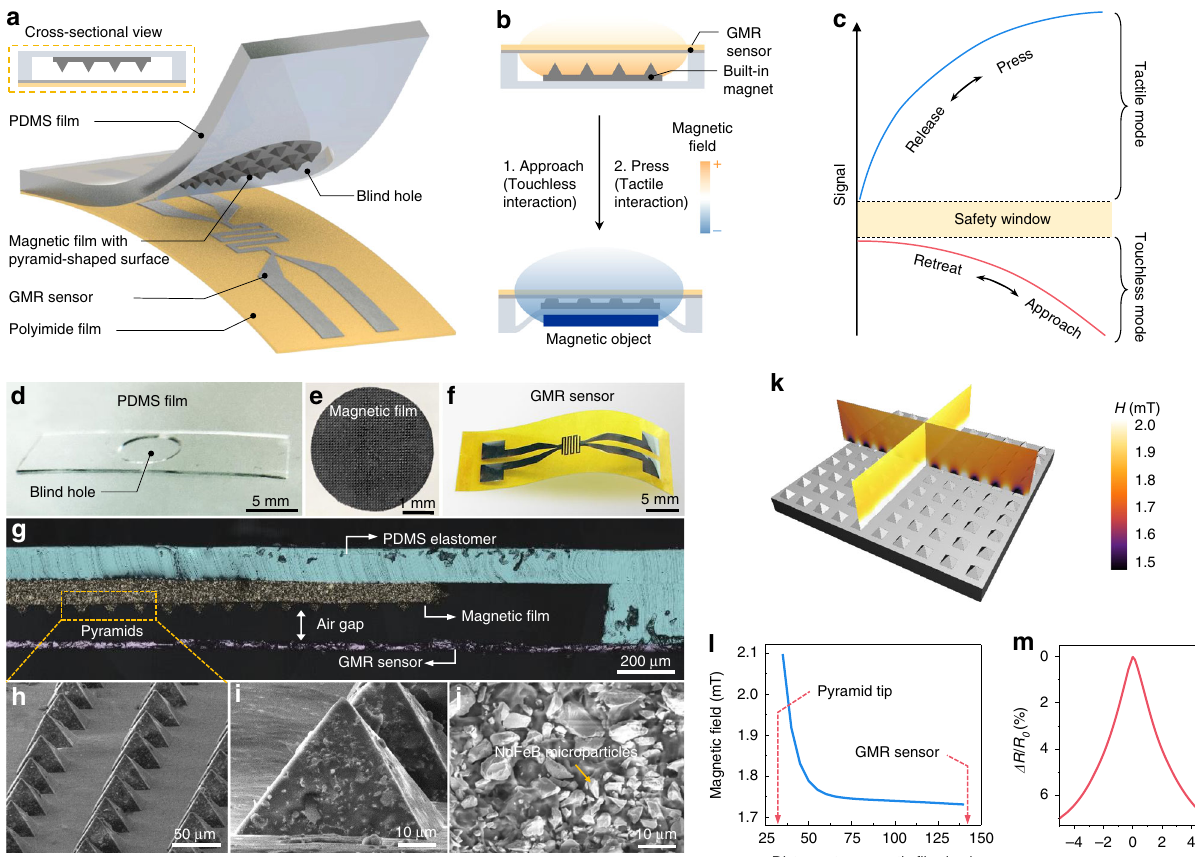
Fig. 1 Assembly and sensing mechanisms of the compliant m-MEMS platform. a Schematic structure of the m-MEMS platform. b Mechanisms of the touchless (proximity) and tactile (pressure) sensing modes. The GMR sensor is biased by the built-in magnetic fi eld (yellow cloud; only the fi eld on the sensor side is sketched) of a compliant permanent magnet with pyramid-shaped extrusions. The m-MEMS is exposed to an external magnetic fi eld with the opposite polarity (blue cloud) to the one of the built-in magnet. c The m-MEMS platform unambiguously discriminates touchless and tactile interaction modes, as the corresponding signals are located at different ranges with respect to a safety window (orange-shaded stripe). Since the signals are not overlapping, this method does not depend on the history of the interaction process (Supplementary Figs. 7 and 11). Optical images of ( d ) a PDMS frame with a blind hole, ( e ) a compliant permanent magnet with pyramid-shaped extrusions on its top surface, and ( f ) a GMR sensor on a polymeric foil. ( g ) Optical microscopy image (with false color) of the cross-section of the m-MEMS platform. SEM images of the pyramid-shaped extrusions in ( h ) low and ( i ) high magni fi cation. j Cross-sectional SEM image of a compliant permanent magnet. k Simulated magnetic fi eld pro fi le above the compliant permanent magnet with pyramid-shaped extrusions (magnetized in a fi eld of 1.5 T, Supplementary Fig. 5). l Simulated magnetic fi eld pro fi le between a pyramid tip and the GMR sensor. m The experimentally measured change of the electrical resistance ( Δ R / R 0 ) of the GMR sensor in response to an applied external magnetic fi eld. Δ R = R 0 − R , R 0 and R are the initial and real-time resistance of the GMR,